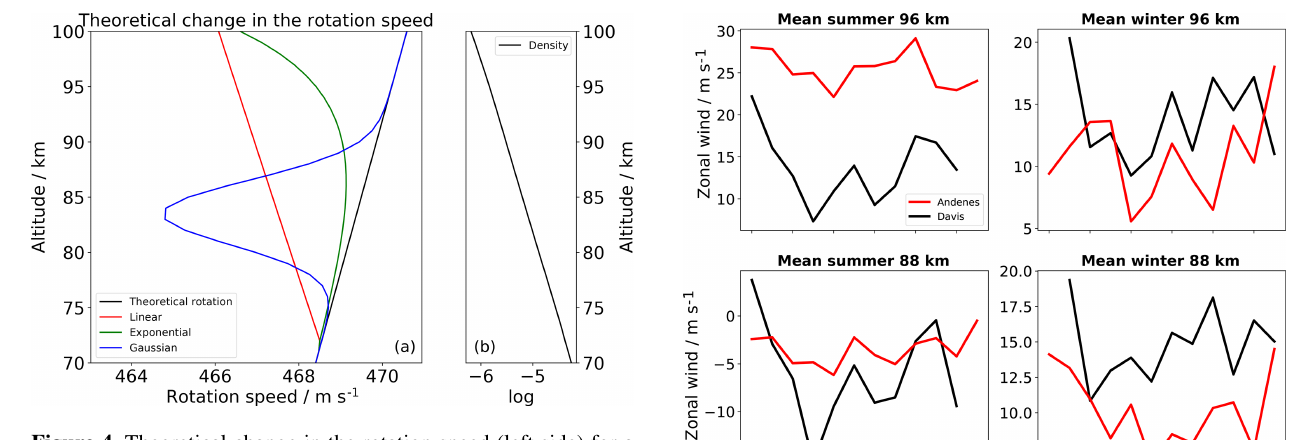
Figure 4. Theoretical change in the rotation speed (left side) for a rigid atmospheric layer. In black we show the theoretical rotation speed of the Earth’s atmosphere and in colors the change due to a density increase of 1% according the legend. On the right side the density progress is shown for specific altitudes. Figure 5. Zonal wind amplitudes for the winter and summer season at 96 and 88km for Andenes and